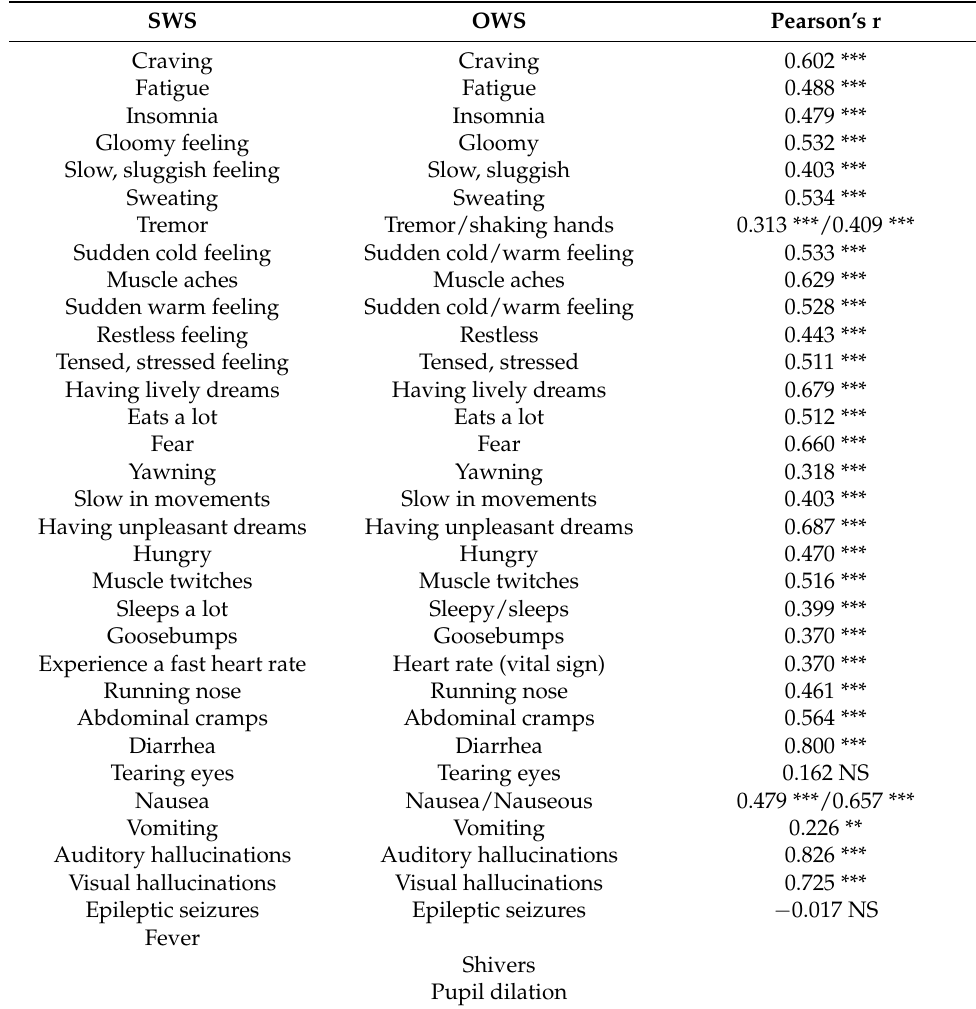
Table A1. Correlation between similar withdrawal symptoms measured with both the subjective- and objective withdrawal scale.